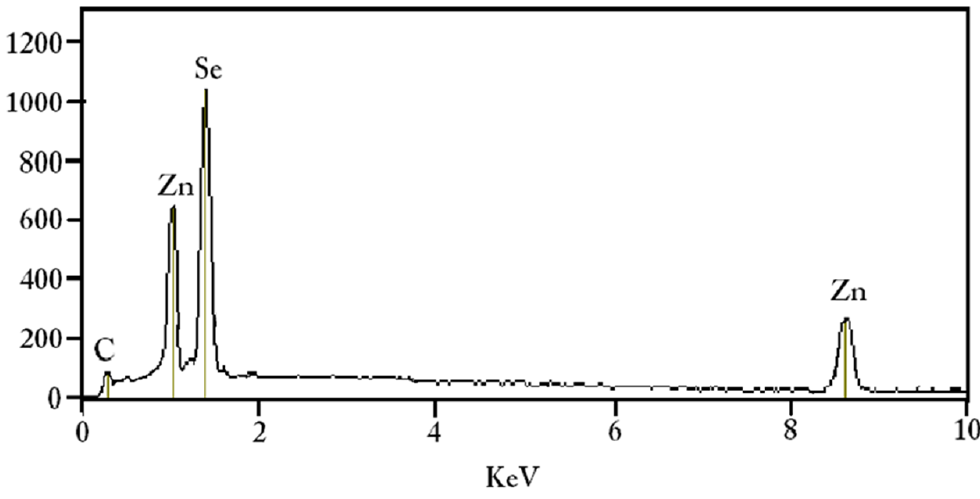
Figure 4. EDX compositional analysis of ZnSe nanoparticles. Table 1. Weight percentages of elements in CdSe and ZnSe nanoparticles samples.